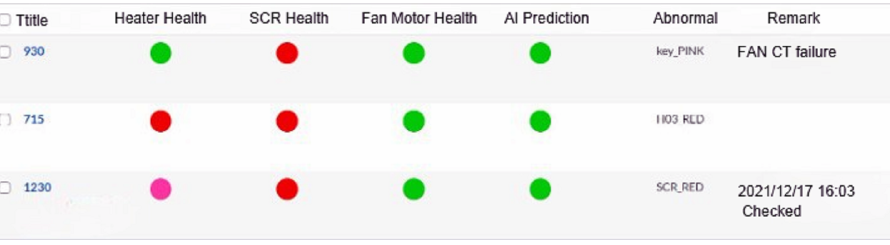
Figure 4. Hot-pressing furnace monitoring